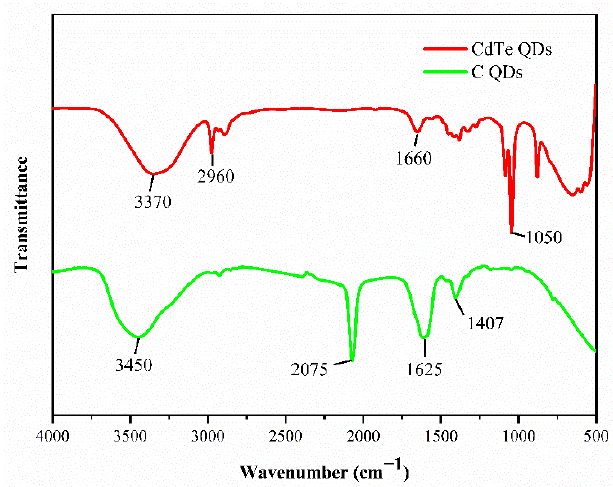
Figure 2. FT-IR spectra of CdTe QDs and C QDs.